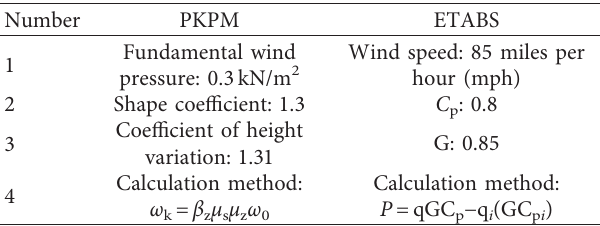
Table 5: Comparison of main wind load parameters between PKPM and